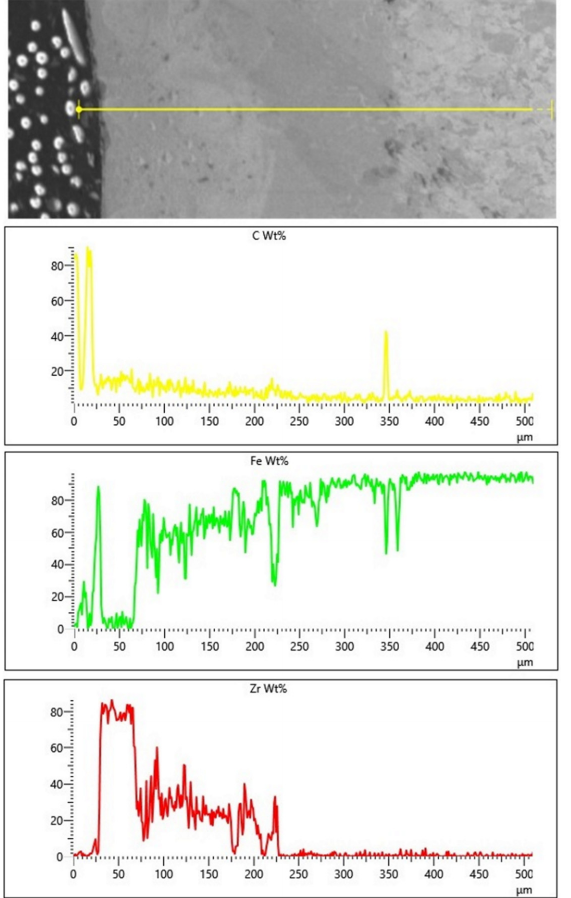
Figure 14. Linear EDS analysis on cross section of Fe/ZrC coating produced using laser beam power 500 W .